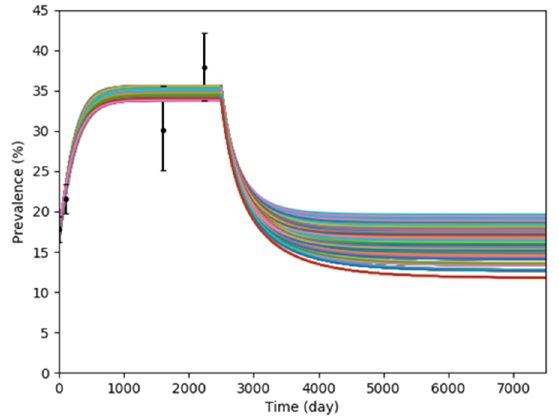
Figure 2. Plot of effect of screening-and-isolation upon admission to MRSA colonization preva- lence.